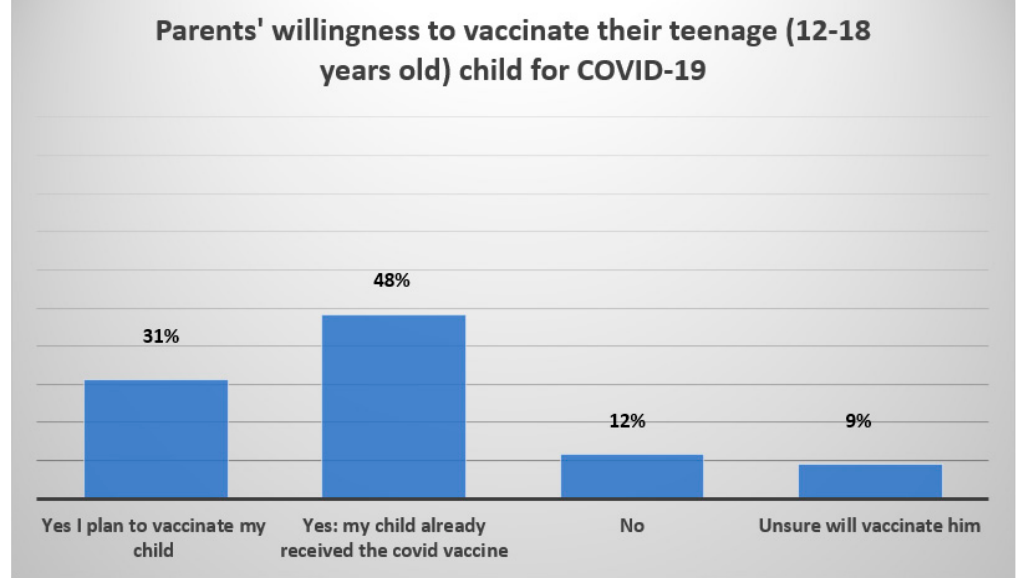
Figure 5. Parents’ reported COVID-19 vaccination status and willingness to vaccinate their teenaged children (12–18 years). Table 3. Multivariable logistic regression analysis of parents’ odds of higher worry from the Omi- cron variant compared to the Delta variant.